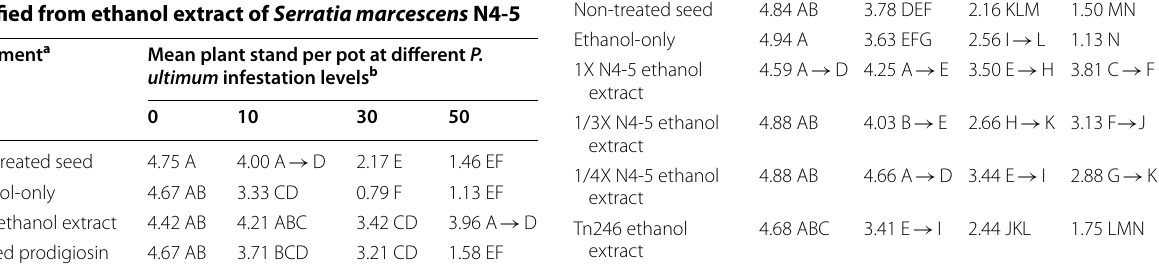
a See “Materials and methods” for a description of treatments. Non-treated, no treatment was applied; ethanol-only, seeds were treated with ethanol only; N4-5 ethanol extract, seeds were treated with ethanol extract of strain N4-5; purified prodigiosin, seeds were treated with purified prodigiosin in ethanol b Values were the mean of three experiments ( n 3) expressed as mean = plant stand per pot. Results were combined prior to analysis as there was no significant experiment treatment effect ( P 0.3975). Treatments in × = all experiments contained eight replicate pots, each containing five seeds. Numbers followed by the same letter were not significantly different ( P 0.05) ≤ as determined by a protected least significant difference test. Least significant difference was 0.97. P. ultimum was added at 0, 10, 30, and 50 sporangia/cm 3 soil-less mix inoculum